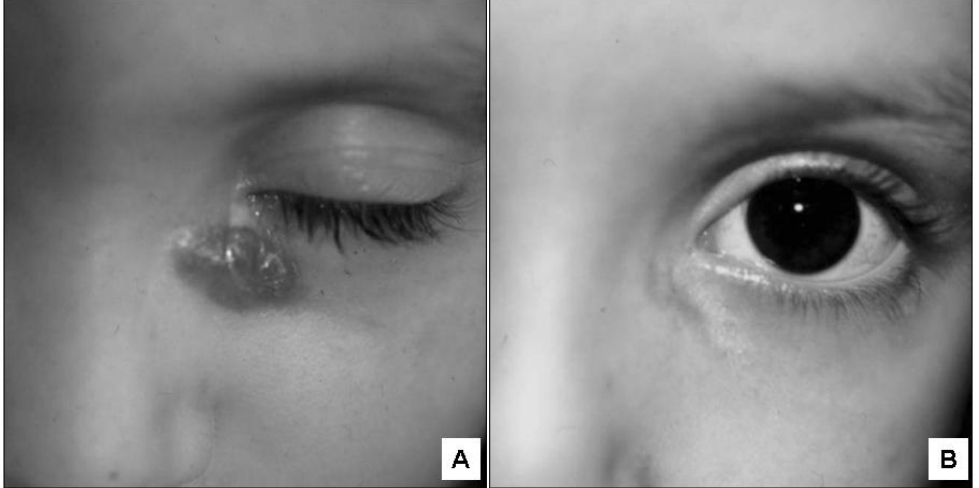
Fig. 3 – Fixed cutaneous form exhibiting a nodular lesion on the face of a child; (A) before treatment and (B) after treatment. The patient was diagnosed by a serological test with the SsCBF antigen.